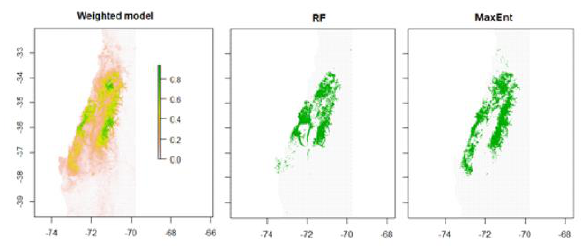
Figure 2 . SDM ensemble model (left) and habitat map from RF model (centre) and MaxEnt (right).